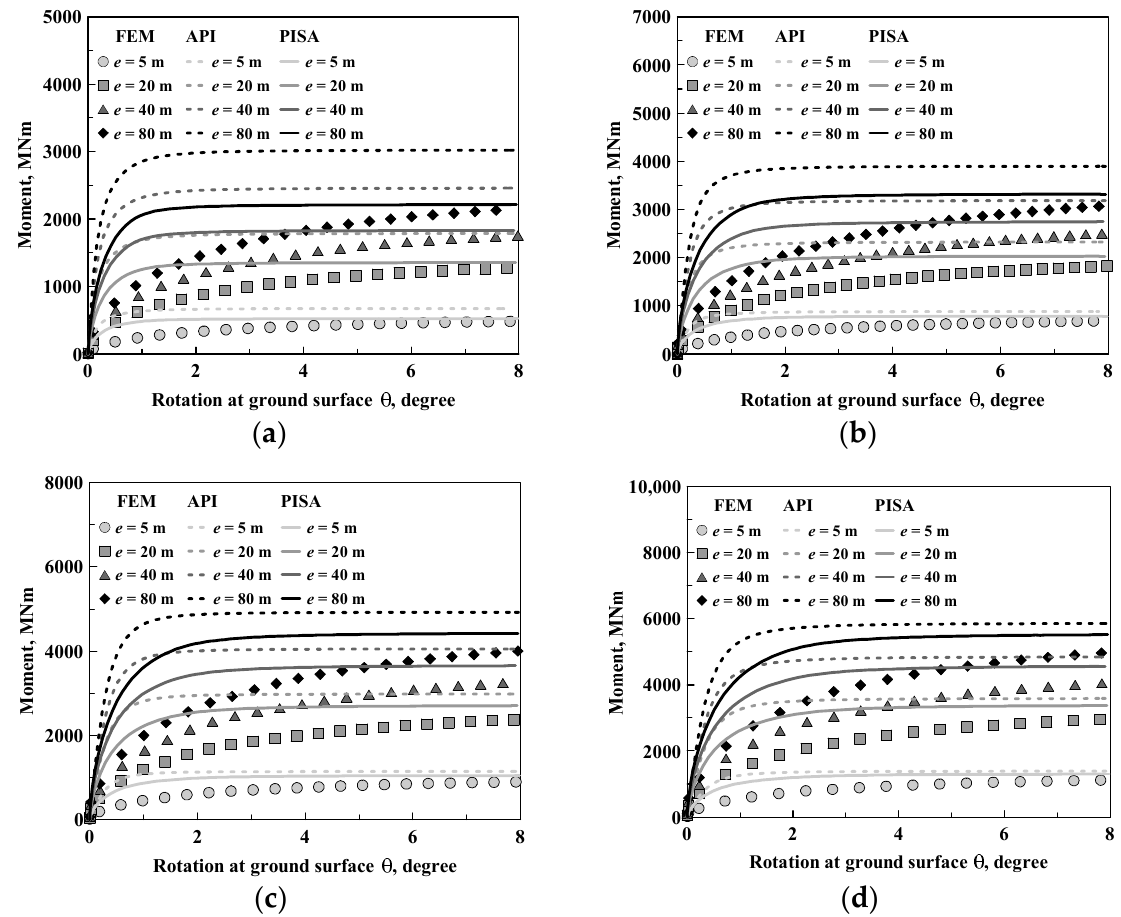
Figure 16. Moment–rotation curves at the ground surface in 80% relative density sand: ( a ) D = 4 m, ( b ) D = 6 m, ( c ) D = 8 m, ( d ) D = 10 m.